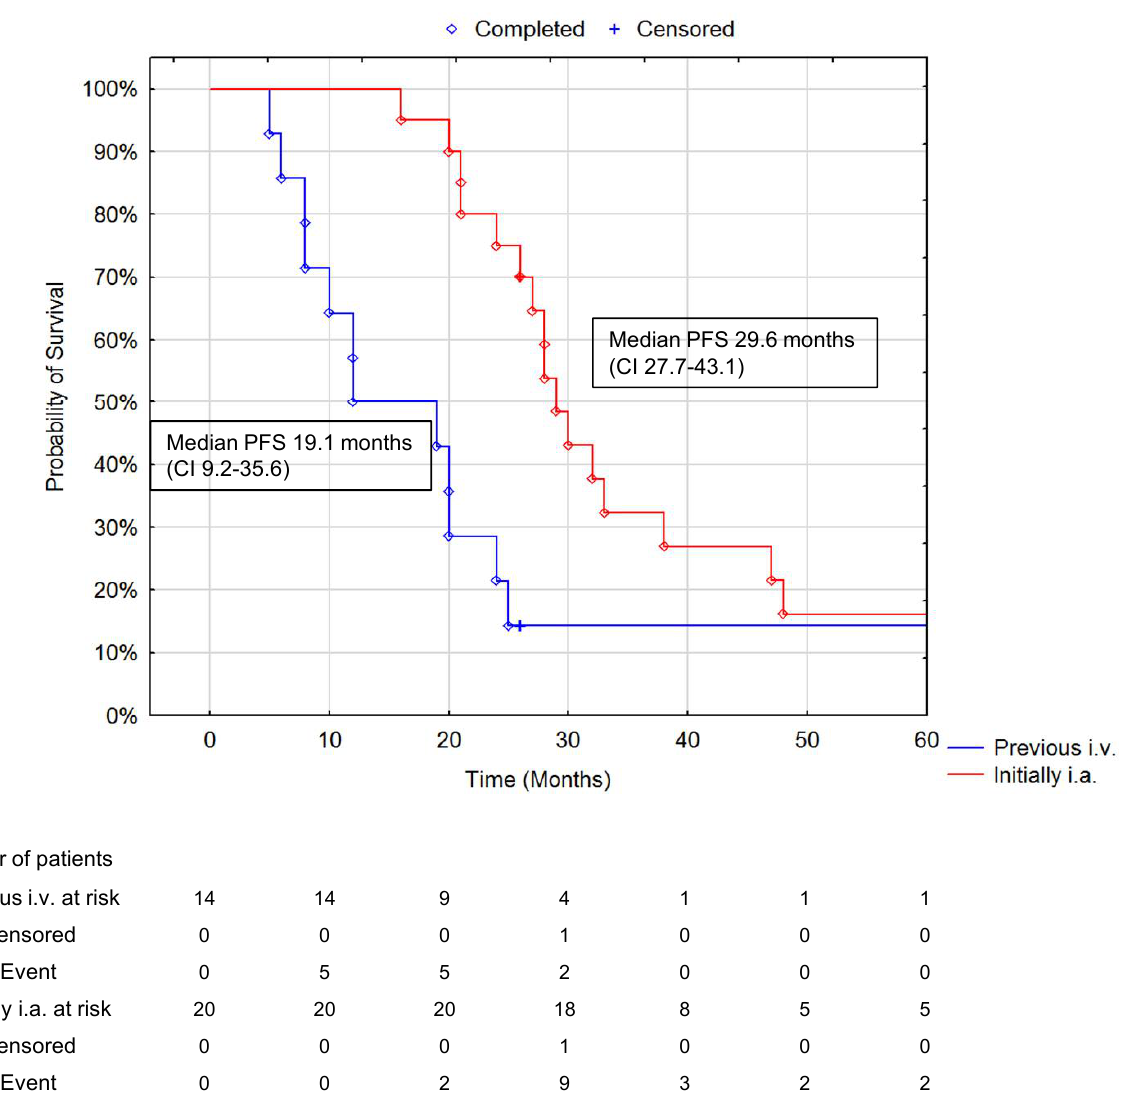
Figure 7. Comparison of PFS in patients with previous i.v. PRRT at 19.1 months (95% CI 9.2–35.6) and initially i.a. PRRT at 29.6 months (95% CI 27.7–43.1) at 12 months of DCR ( p = 0.026 Cox–Mantel test). Disease control rate was defined as the proportion of patients with partial response (PR) or stable disease (SD), not patients with complete response (CR). The number of subjects remaining at risk was below 10% of cases in any